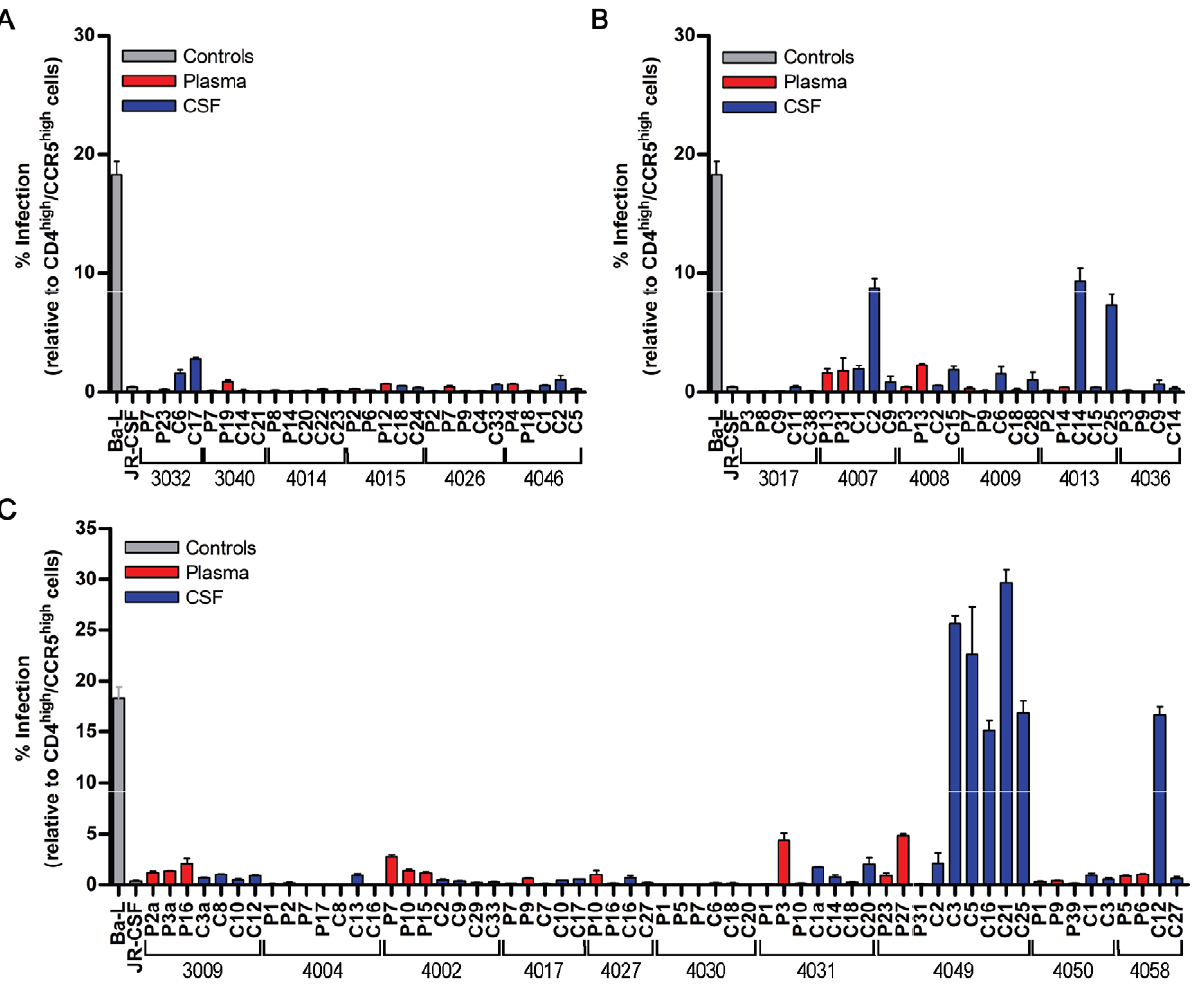
Figure 5. Compartmentalized HIV-1 CSF populations in children can have a low CD4 entry phenotype. Single-cycle infection of HIV-1 Env-pseudotyped reporter viruses on CD4 low CCR5 high 293-Affinofile cells [34]. Receptor expression was measured as follows: CD4 low =1,702 receptors/cell, CD4 high =63,387 receptors/cell, CCR5 high =26,117 receptors/cell. The data are averaged from triplicate wells for each of 2 to 3 env clones that were generated per indicated amplicon. Amplicons were selected for cloning to represent different portions of the phylogenetic tree. Panels show infection results for: (a) equilibrated subjects; (b) intermediate; and (c) compartmentalized subjects. Selected HIV-1 env sequences are indicated by a black square followed by the env name on neighbor joining trees for several subjects (Figure